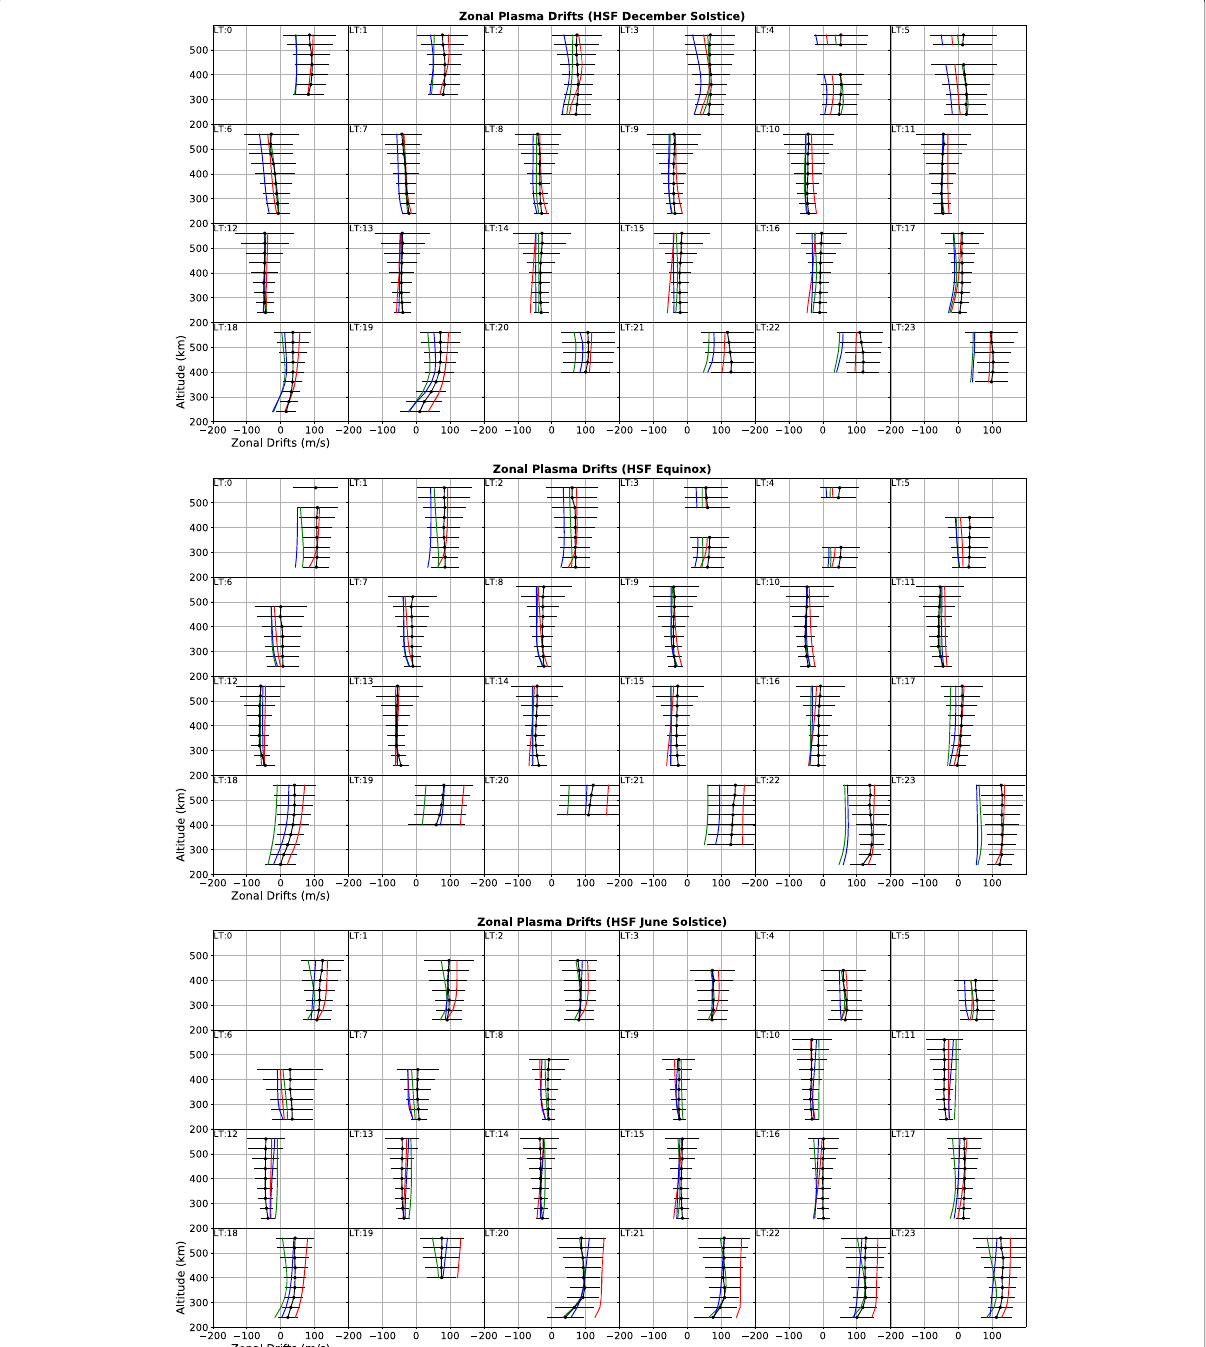
Fig. 5 Altitude profiles for the three seasons during HSF conditions. The blue, green, and red lines represent model zonal plasma drifts using HWM14, HWM07, and HWM93, respectively. The black curves and error bars represent the average and standard deviations of the Jicamarca zonal plasma drifts,